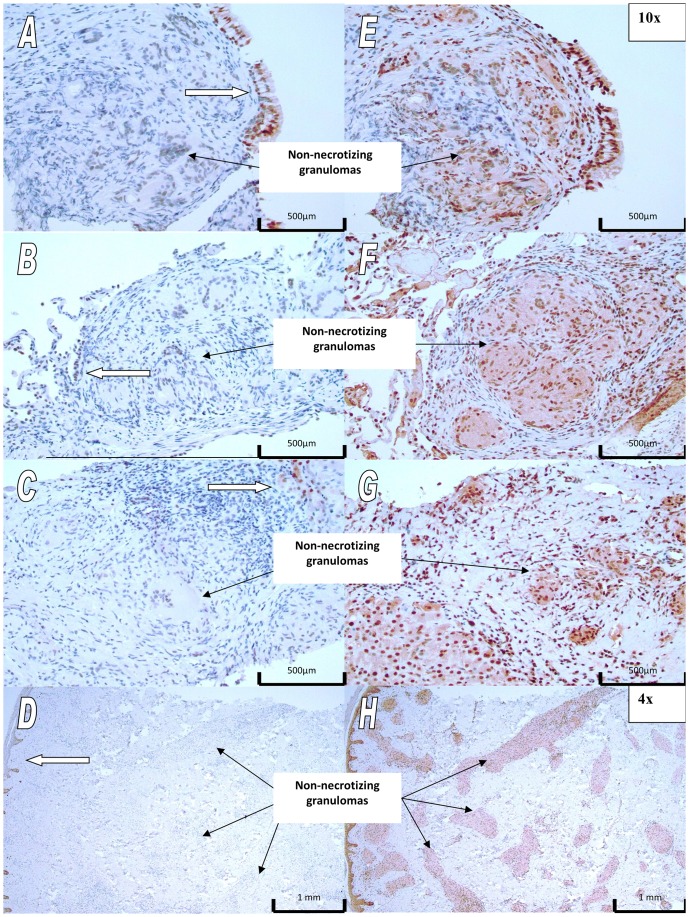
Representative pictures of XAF1 and XIAP staining of sarcoidosis-affected tissues.Panels A–D depict XAF-1 staining; panels E–H depict XIAP staining. Panels A and B are bronchial mucosa; E and F are lung tissue; C and G are liver tissue; and D and H are skin tissue. In general, XAF1 staining is negative in sarcoidosis-affected areas and limited to epithelial cells at the periphery (white arrows). XIAP staining was positive, with greater intensity observed in non-caseating granulomas.